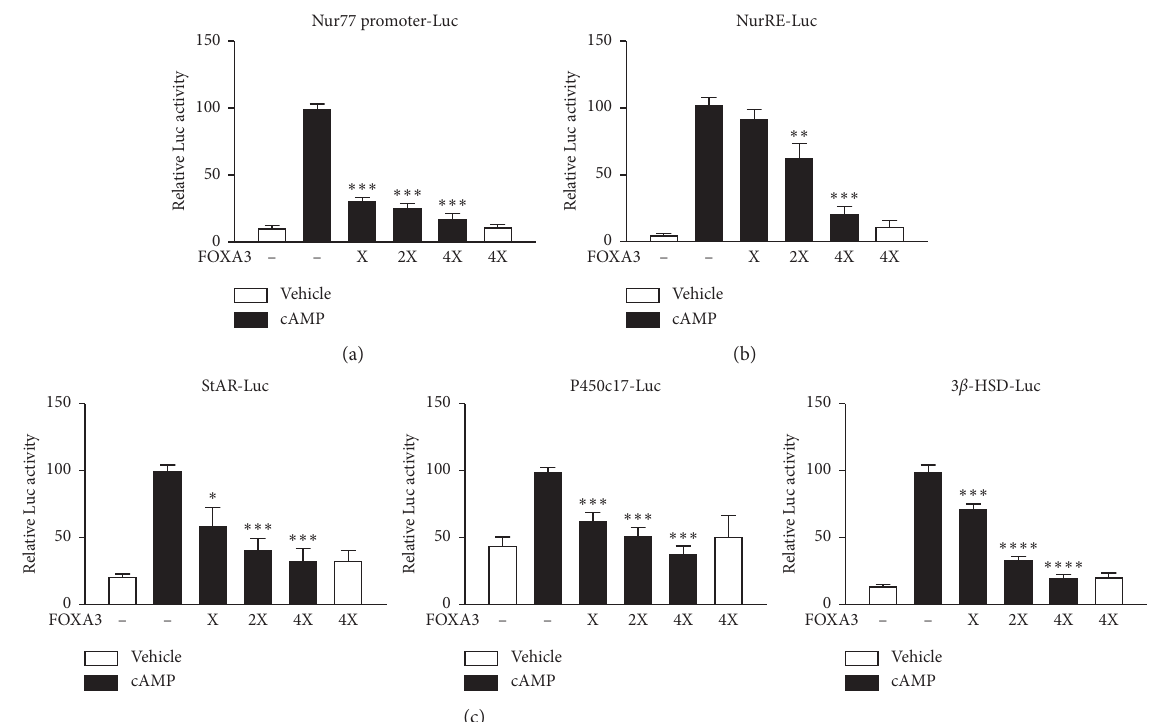
Figure 2: FOXA3 represses cAMP-induced promoter activity of Nur77 and its target steroidogenic genes. FOXA3 strongly represses cAMP- induced promoter activity of Nur77 (A) and Nur77 responsive element Nur-RE (B) in a dose-dependent manner. Nur77 target ste- roidogenic gene promoters are also repressed by overexpression of FOXA3 in cAMP-stimulated MA-10 Leydig cells (C). Cells were transfected with different reporter constructs, SV-40 β -gal, and indicated concentration of FOXA3 (X represents 100 ng of the expression construct and 2X and 4X represent the fold amounts of (X)) for 48 h that included overnight cAMP induction (200 μ M). Luciferase activity was normalized to β -galactosidase activity. The cAMP-induced controls were considered 100% for comparison, and the t -test was performed to analyze statistical significance. ∗ P < 0 . 05; ∗∗ P < 0 . 01; ∗∗∗ P < 0 . 001; ∗∗∗∗ P < 0 .